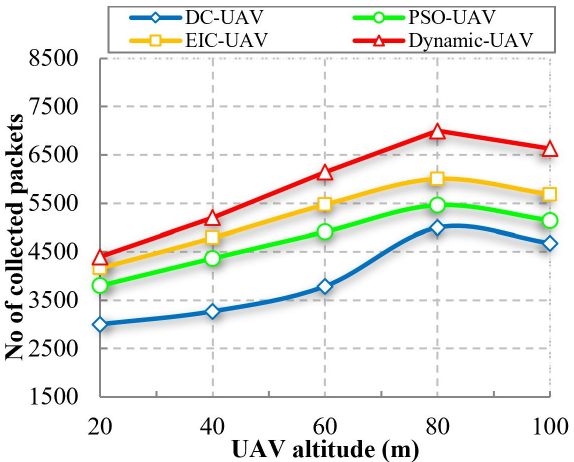
Figure 14. Number of collected packets to UAV altitude.